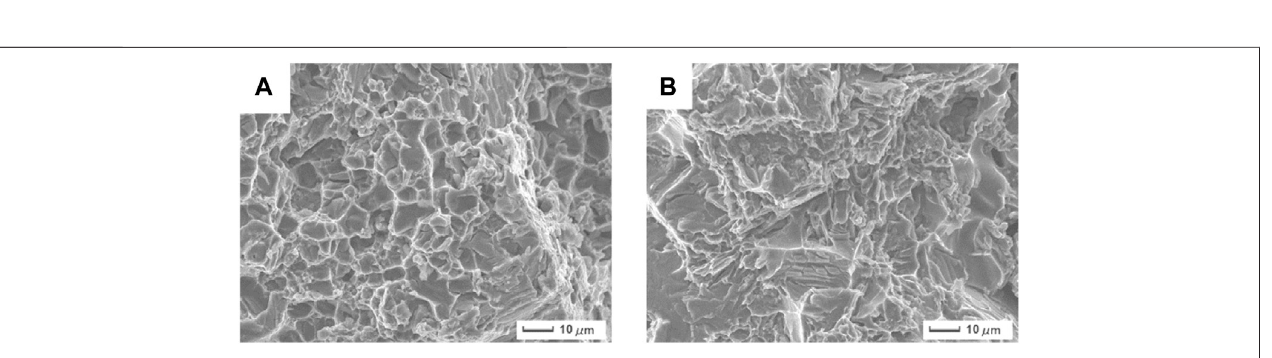
FIGURE 12 | The SEM fractographs of the fracture of TiB 2 /A356 in-situ composites on (A) as-cast and (B) T6